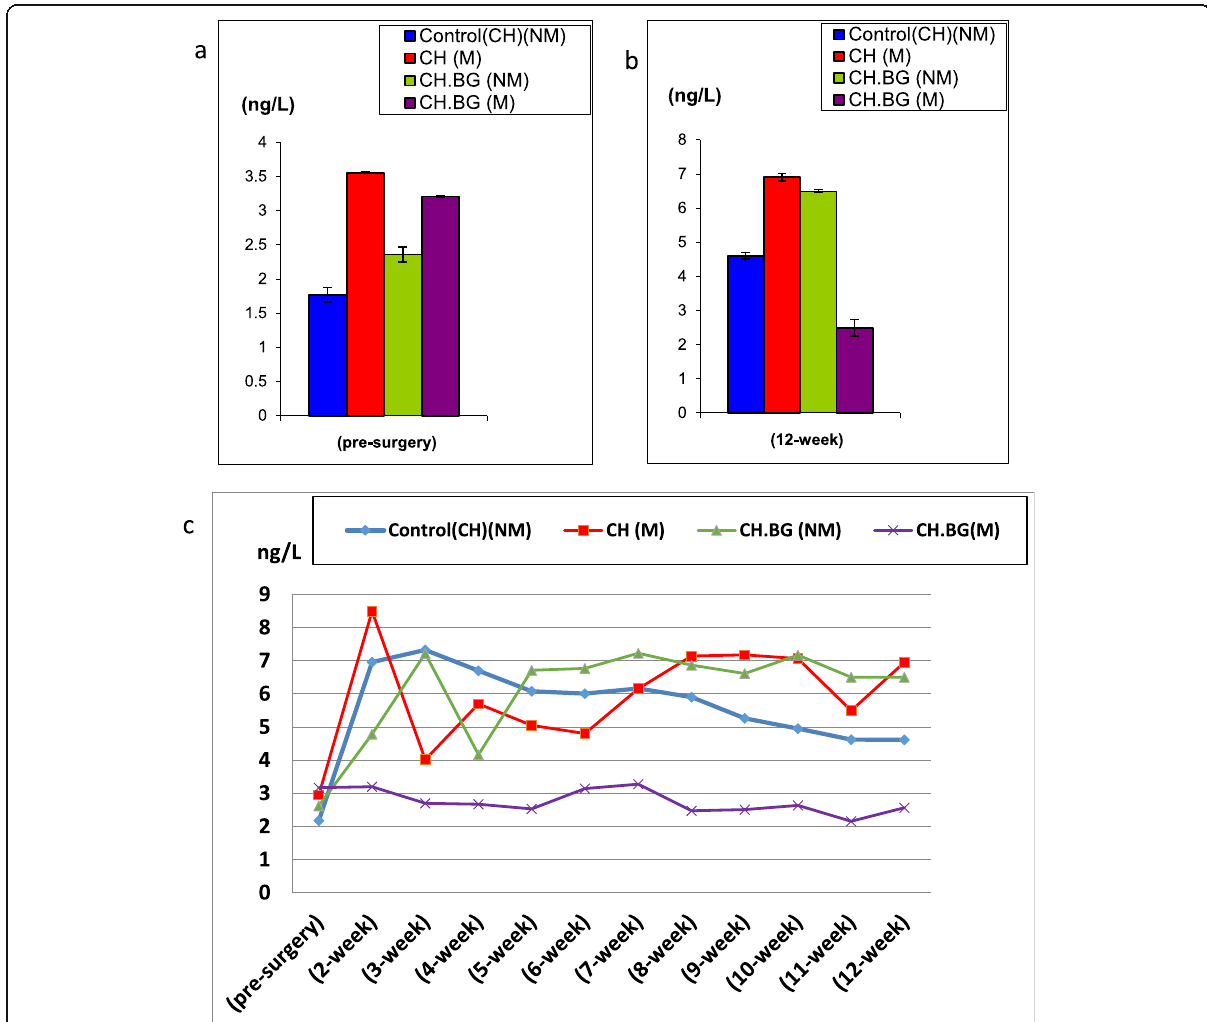
Fig. 2 Mean ± SD of dog serum VEGF level in the different groups. a Pre-surgery. b 12 weeks. c During